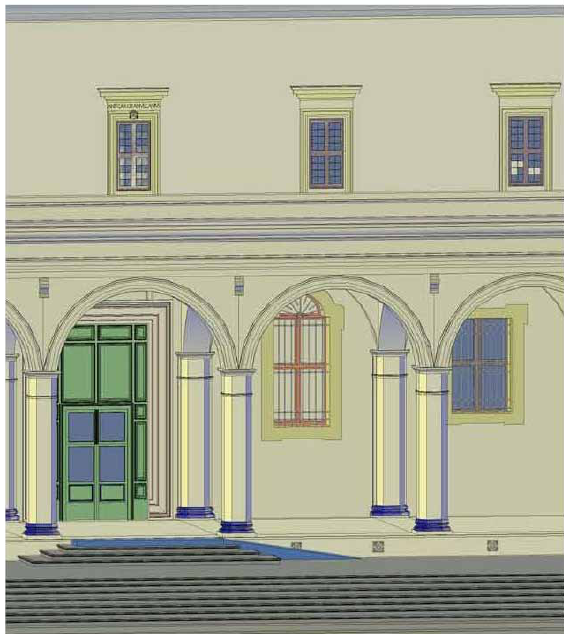
Figure 24. Detail view of the virtual model of the entrance